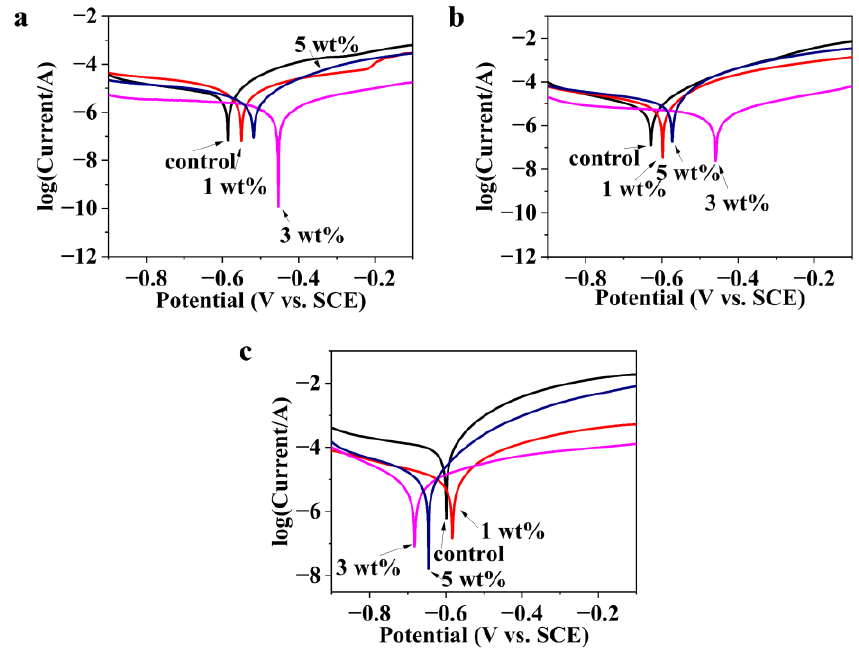
Figure 9. Potentiodynamic polarization curves of different coatings in 3.5wt% NaCl solution for ( a ) 48 h, ( b ) 144 h, and ( c ) 840 h. Table 2. Tafel electrochemical measurement data of different coatings for different times.